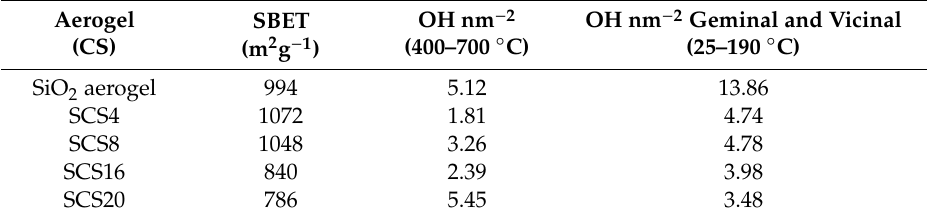
Table 2. Hydroxyl groups content on the aerogel surface from TGA weight drops. SBET (specific surface area from BET